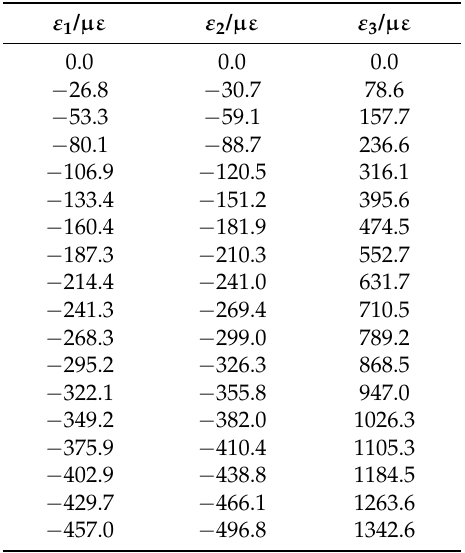
Table 2. The strain measurement results of FBG sensors and resistance strain gauges. ε 1 / µε ε 2 /